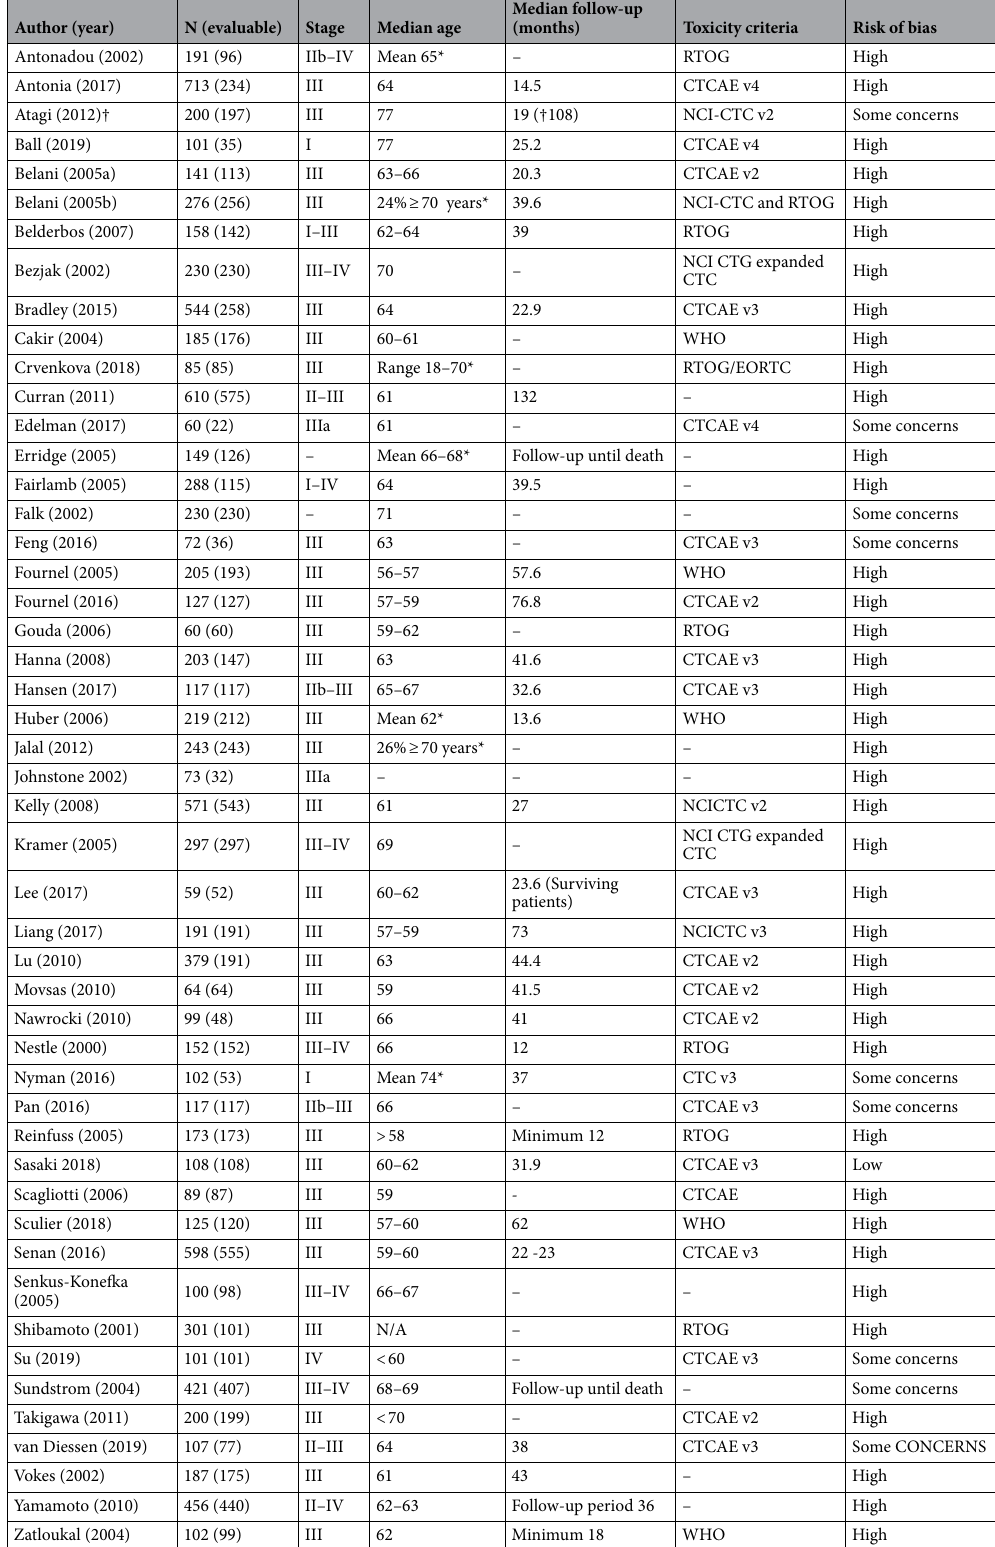
Table 1. Patient and study characteristics of included trials. *Median not reported. † Updated in 2018, includes censored cases. – Not available. Belani (2005a)—ECOG 2597. Belani (2005b)—Combined chemoradiotherapy regimens of paclitaxel and carboplatin for locally advanced non-small-cell lung cancer: A randomized phase II locally advanced multi-modality